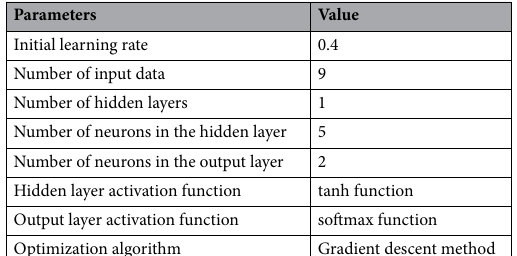
Table 5. The correct prediction rates in Table 5 are the correct rates given directly after the SPSS software MLP